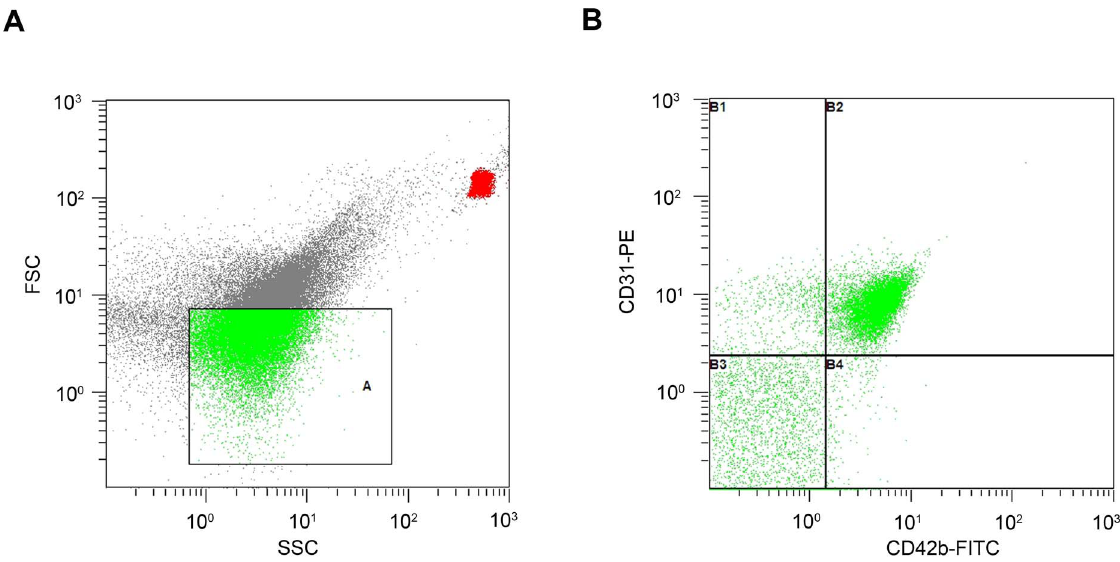
Figure 1. Representative graphs of flow cytometry analysis of circulating microparticles from one of the subjects. A. Circulating microparticles are represented on a forward scatter/side scatter dot plot. Total microparticles are defined as events with a size of 0.1 to 1.0 m m gated in window A using 1 m m-diameter calibrant beads as interior criterion prior to the sample testing. B. Size-selected events are plotted according to their fluorescence for specific CD42b-FITC(PMT2) and CD31-PE(PMT3) binding on a two-fluorescence plot. Events included in B1 section (CD31 + / CD42b-) were considered microparticles mainly of endothelial origin.